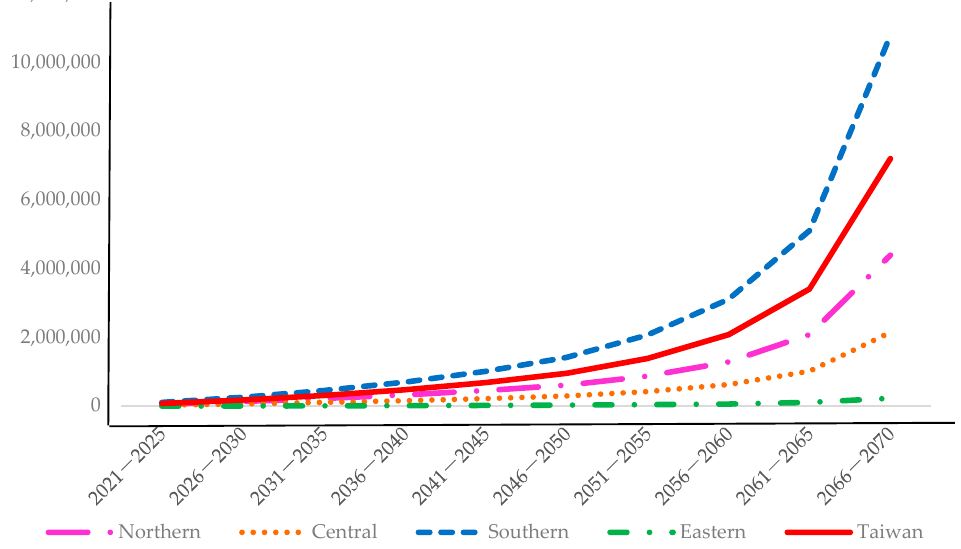
Figure 2. Net BPT for each region and the whole county under the implementation of dioxin-emission reduction action.